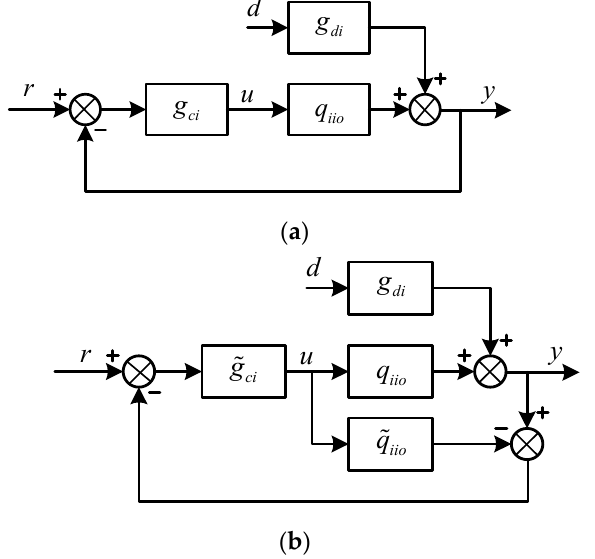
Figure 5. The one-degree-of-freedom feedback control diagram: ( a ) classical feedback control; ( b ) internal model control.